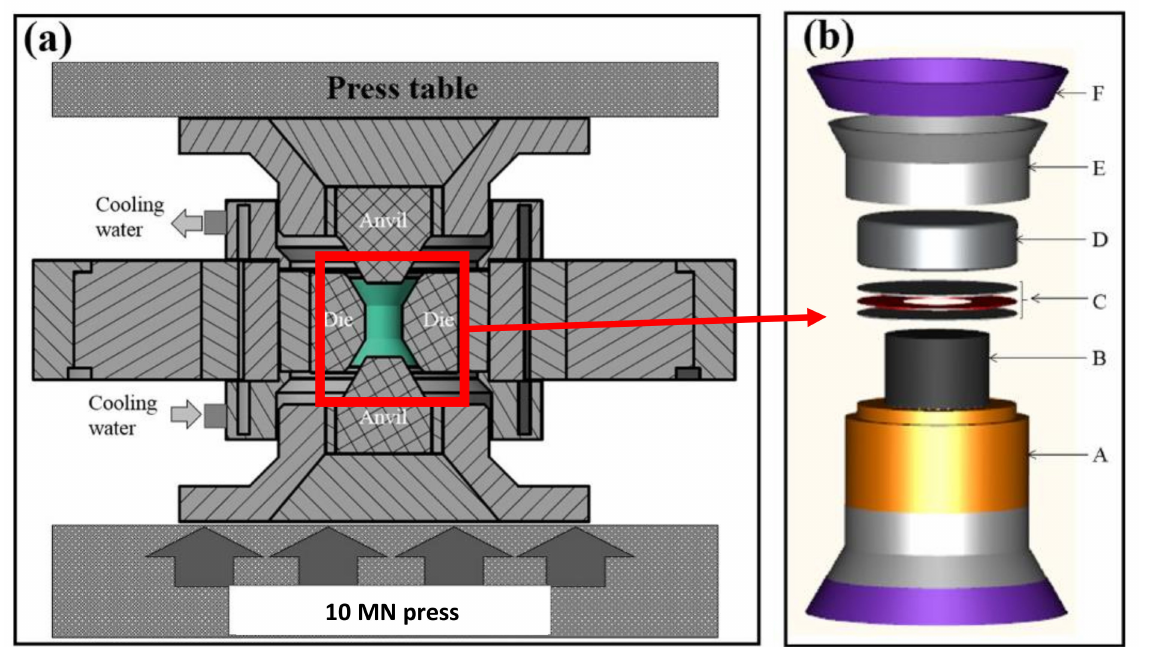
Figure 11. ( a ) HP-SPS belt apparatus showing the high-pressure reaction chamber (in green), where the sample is located, and the external support (the “belt”), used to contain the pressure. ( b ). High- pressure reaction chamber: A: Fired pyrophyllite tube; B: Graphite heater; C: Molybdenum discs sandwiching mica ring; D: Steel cover filled with fired pyrophyllite pellet; E: Crude pyrophyllite gasket; F: Polymer gasket (adapted from